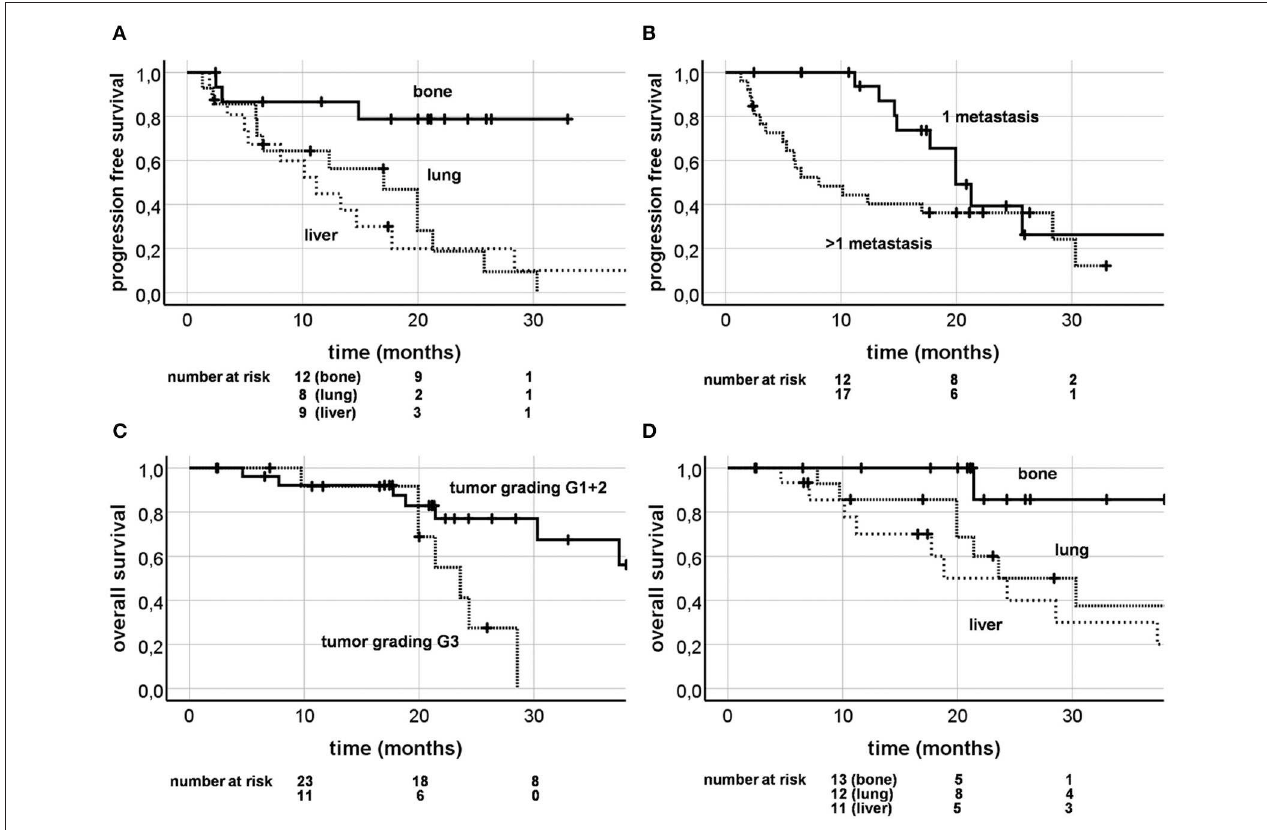
FIGURE 4 | Kaplan-Meier curves; progression free survival depending on the irradiation site ( A ; p = 0.004) and present metastases ( B ; p = 0.084); overall survival depending on tumor grading ( C ; p = 0.026) and on irradiation site ( D ; p = 0.038).